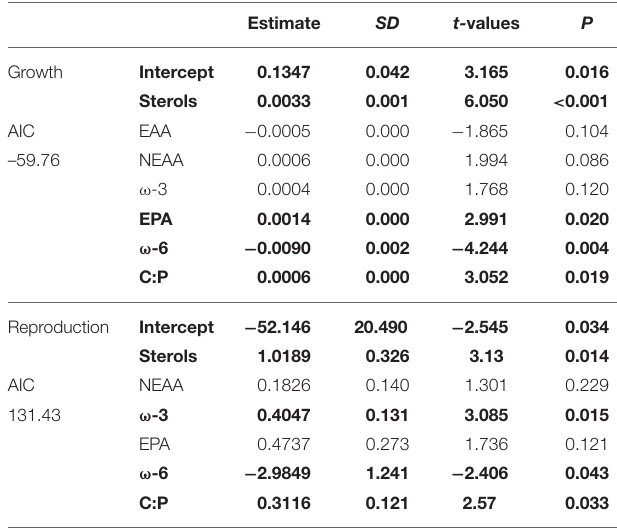
TABLE 2 | GLM results for Daphnia growth and reproduction when all of studied phytoplankton strains were included in analysis. Estimate